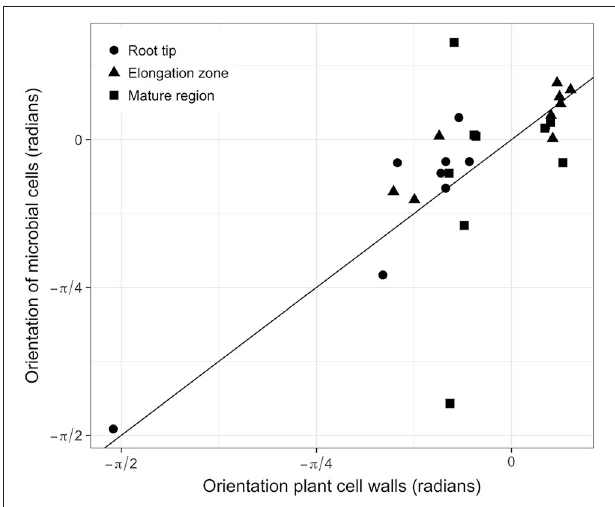
FIGURE 7 | Relationships between the orientation of root cells and the angle at which the pair orientation function is maximum for all observed distributions. Solid line is the 1:1